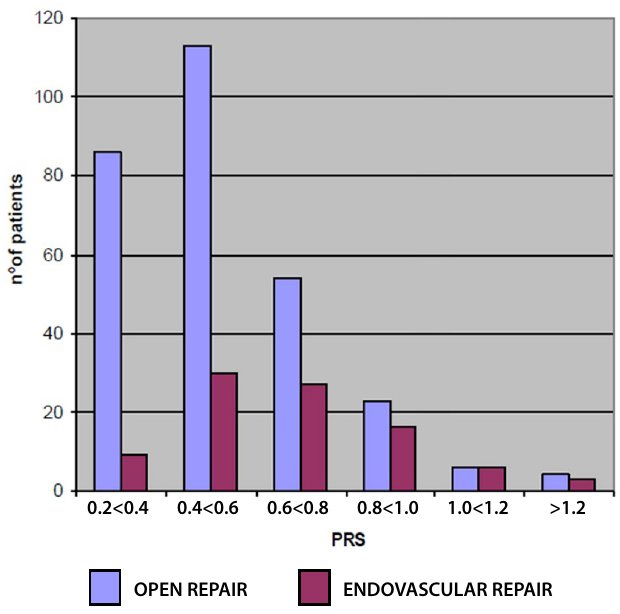
Fig. 1 - Distribution of patients according to surgical technique and physiologic risk score (PRS)